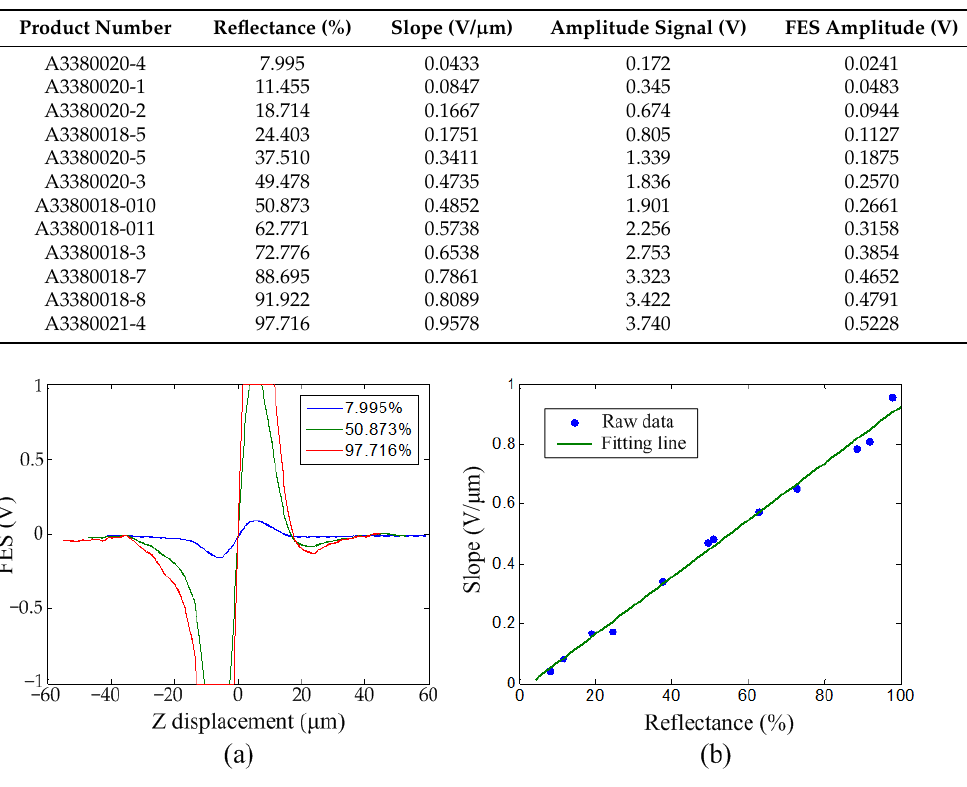
Figure 3. ( a ) FES vs. Z-axis displacement curves and ( b ) relationship between the slope of linear region and reflectance for optical filters with varying reflectances.